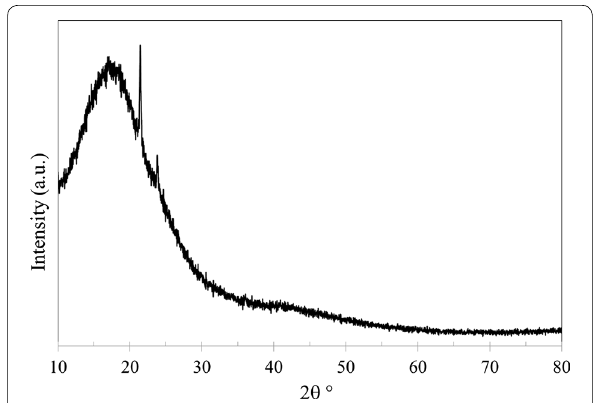
Fig. 12 XRD analysis of GBL membrane made by 27 wt% PEI